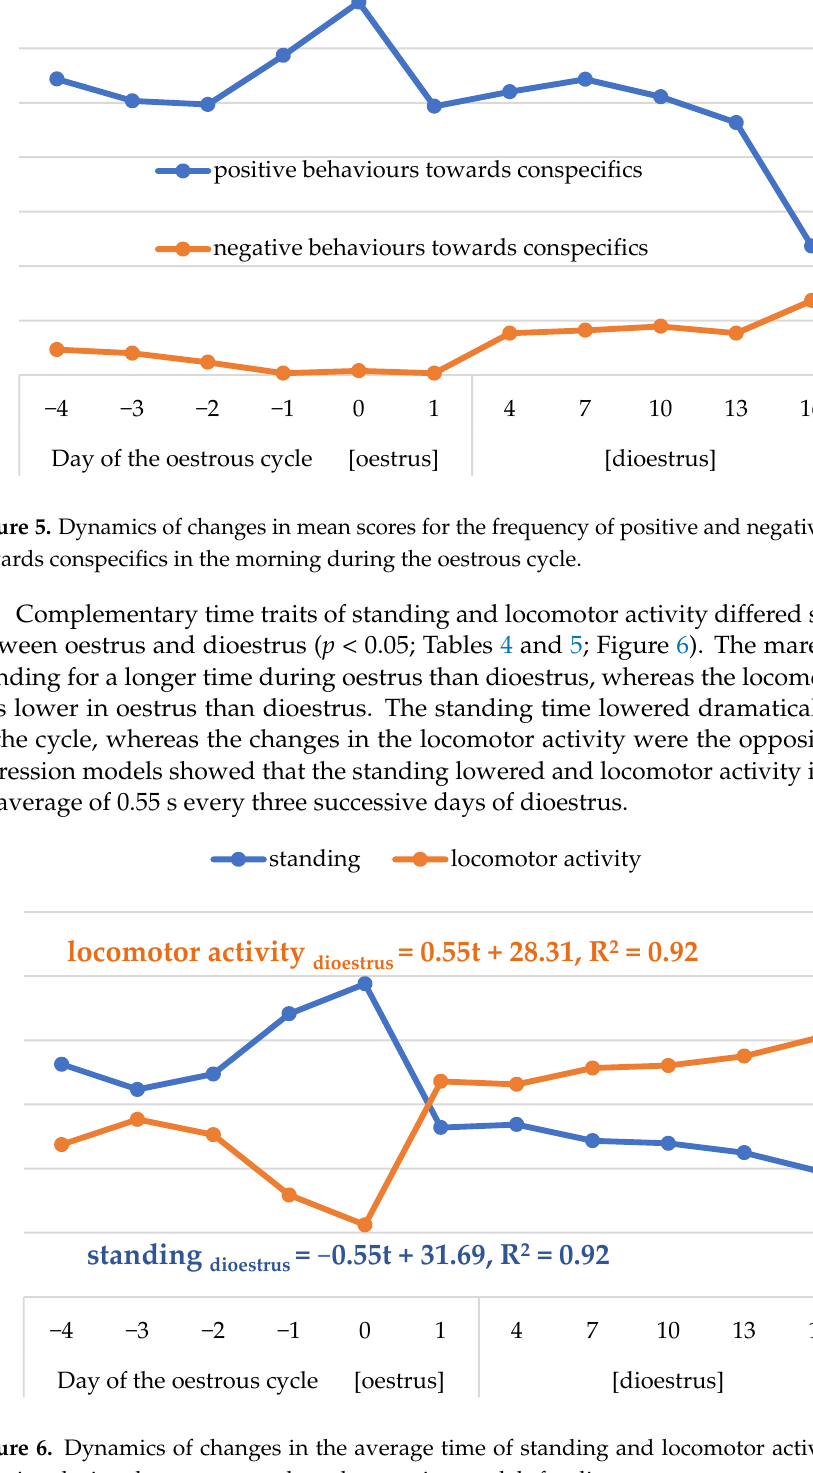
Figure 4. Dynamics of changes in mean scores for the behaviour towards human in the morning and evening during the oestrous cycle and regression models for oestrus.